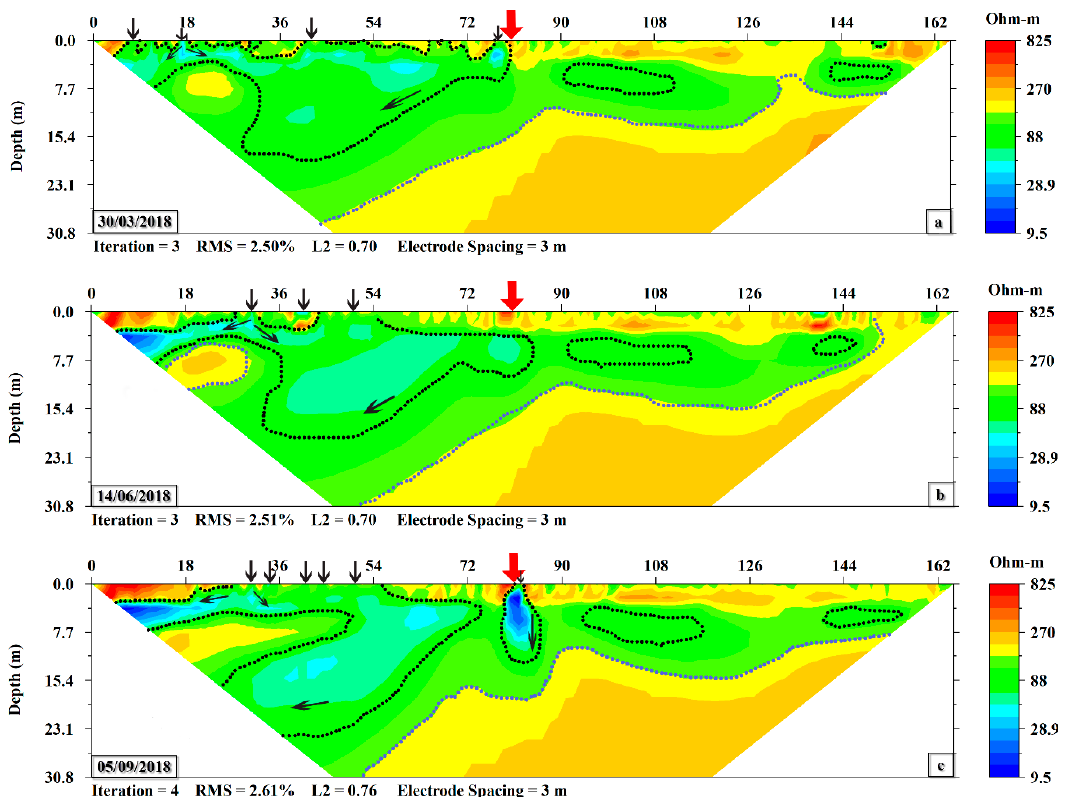
Figure 8. Electrical resistivity tomography of line two. The red arrow indicates location of resistivity log at 81m distance: ( a ) 30 March 2018; ( b ) 14 June 2018; ( c ) 05 September 2018. The most conductive zone (dark to light blue color) with resistivities from 9.5 Ω m to 40 Ω m shows variations in shape across the three dates (March, June, and September). The variation is prominent in the June and September profiles as shown in the three tomographies (Figure 8, demarcated by black dotted lines). The overall variation of the zone indicates water flux movement. At the distance of 81 m (marked by red arrow), the zone extends from 3 m depth in March to around 12 m depth in September. The extension of the low resistivity indicates the vertical movement of water in the vadose zone. Similarly, the low resistivity horizon shows variation between 18 m and 68 m distance (marked by inclined black arrows), indicating water infiltration both vertically and horizontally. In this profile, there is a crescent shape conductive zone associated with preferential flow from the vadose zone at 18 m marked by vertical black arrows in (b) and (c) of Figure 8. The resistivity changes in the profiles indicate groundwater flow into the Rieng stream located on the left parts of the profiles. In this area, the average groundwater level is 4.0 m (bgl), varying by about 1 m below or above the Rieng stream bed, depending on the season. This implies that groundwater is discharging as a base flow through the Rieng stream. The second dominant zone represented by yellow/red color and demarcated by a blue dotted line has resistivity range from 200 Ω m to 825 Ω m. This zone dominates the left side of the profile. The horizon regularly extends from 40 m to 165 m. This zone is interpreted to represent granite bedrock and can be easily identified in the well log data and resistivity log (Figure 2 and Figure 9b).